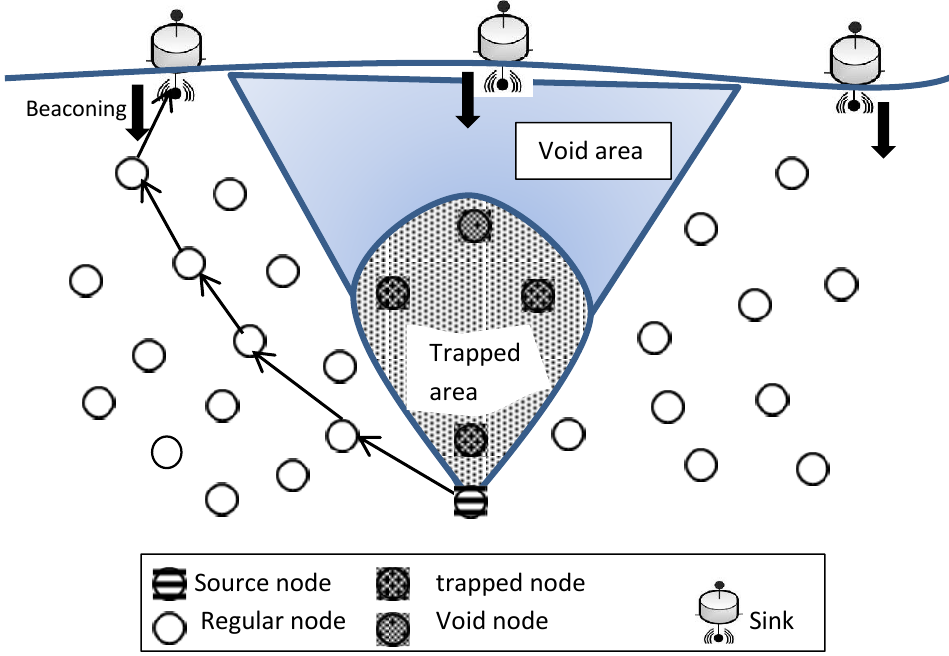
Figure 6. VAPR voids and trapped areas. GEDAR